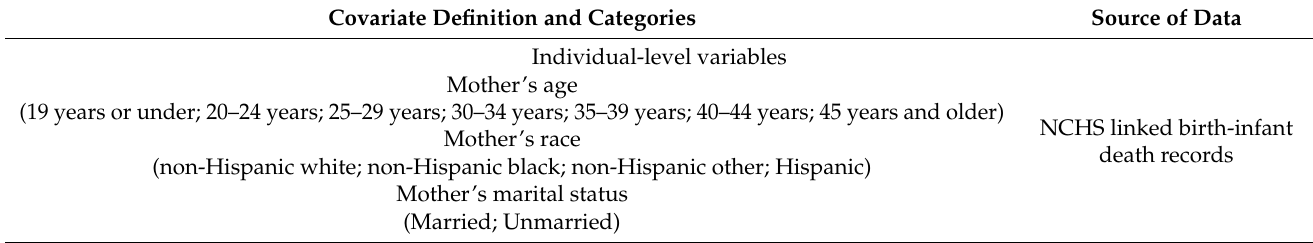
Table A1. Covariate definition and data